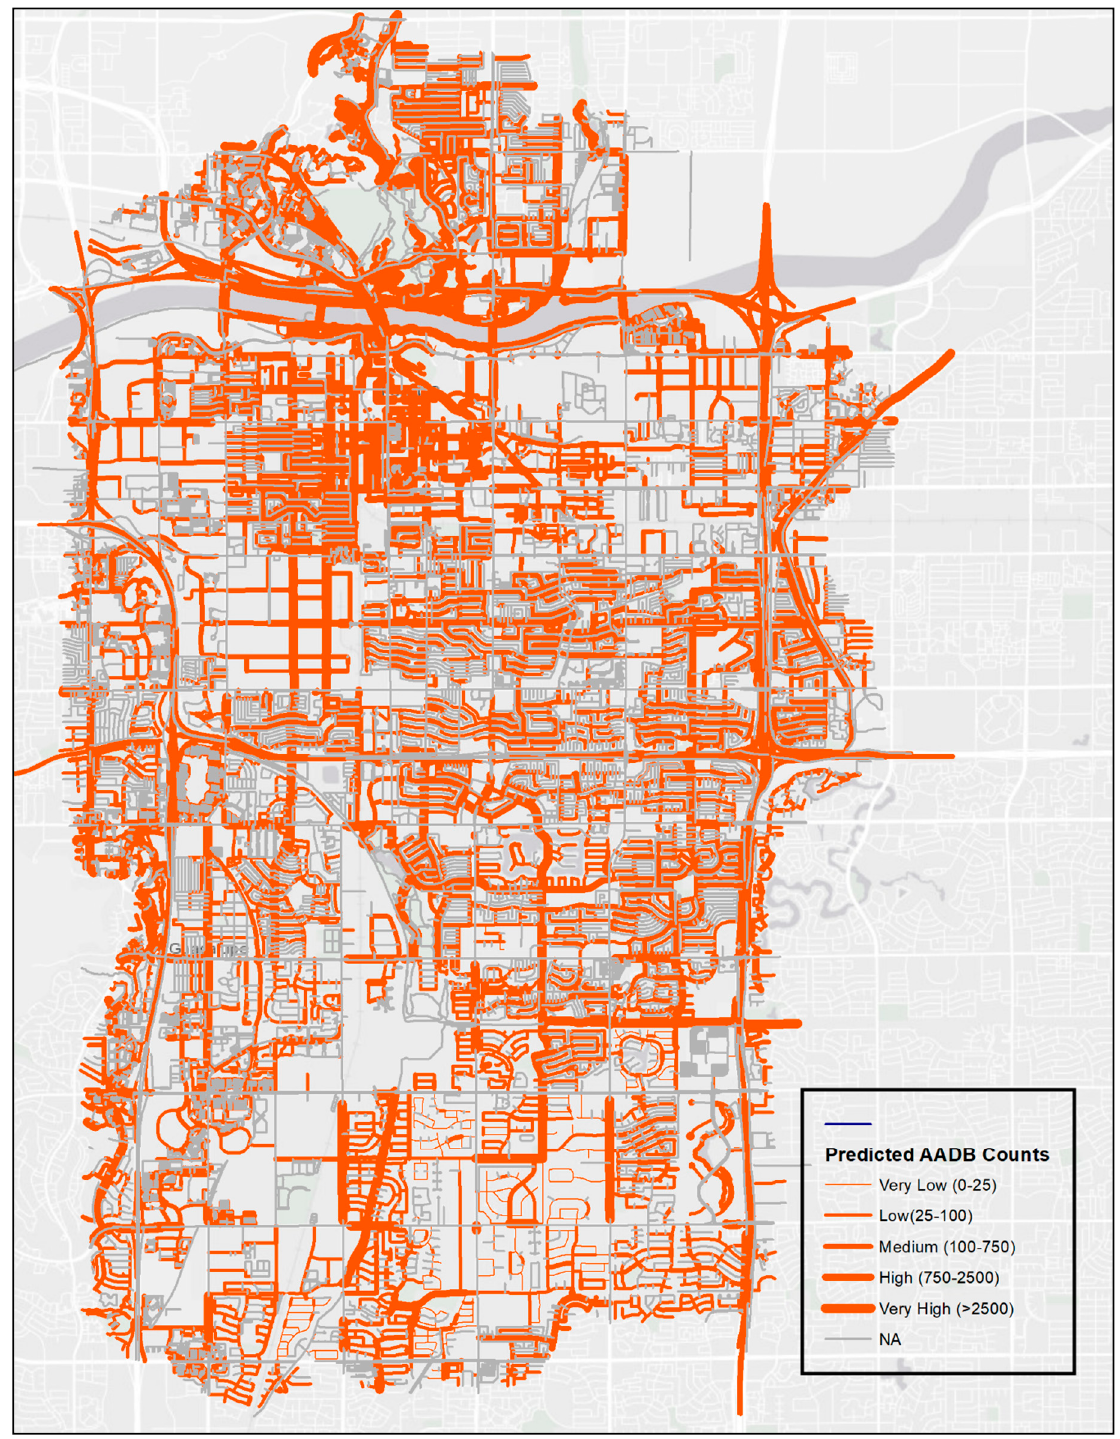
Figure 7. Predicted bicycle AADB counts for the entire street network of Tempe in 2016.